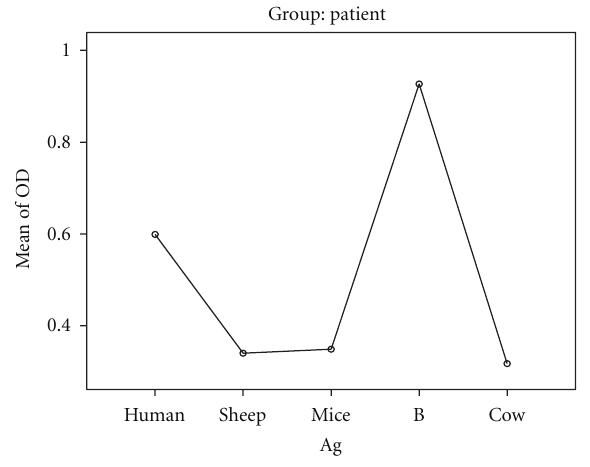
Figure 2: The mean OD values of total Human IgG response against mice, cattle, human, and sheep HCF along with antigen